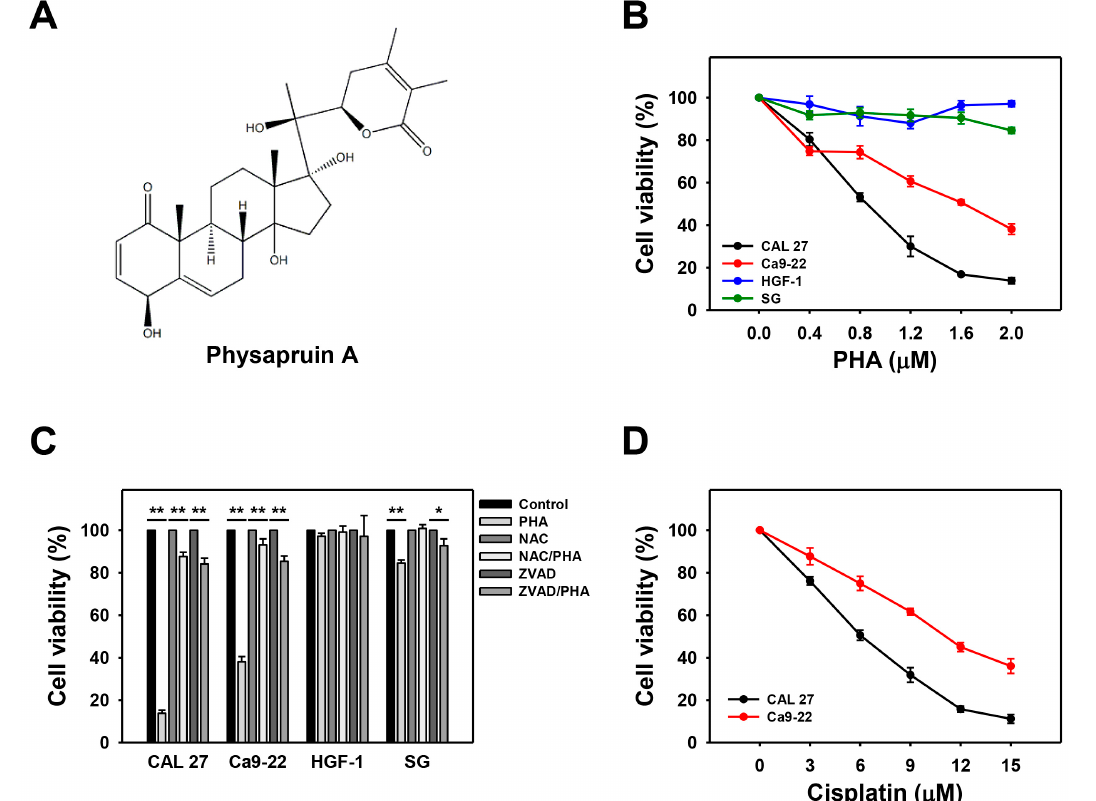
Figure 1. PHA selectively decreases the cell viabilities of oral cancer cells but not for non-malignant oral cells. ATP content after 24 h drug treatment was used for cell viability determination. ( A ) Structure of PHA. ( B ) Cell viability ATP assay. Two oral cancer (CAL 27 and Ca9-22) and two non-malignant oral (HGF-1 and SG) cell lines were examined. Cells were exposed to 0 (0.1% DMSO medium as control), 0.4, 0.8, 1.2, 1.6, and 2 µ M PHA for 24 h. ( C ) Suppression of PHA-induced antiproliferation by N -acetylcysteine (NAC) or Z-VAD-FMK (ZVAD). To evaluate the recovery effect of NAC and ZVAD, NAC (10 mM for 1 h) or ZVAD (100 µ M for 2 h) were added to cells before a 24 h treatment with PHA (control (0.1% DMSO medium) and 2 µ M), i.e., NAC/PHA or ZVAD/PHA. ( D ) Cisplatin sensitivity to oral cancer cell lines at 24 h ATP assay. Data, means ± SDs ( n = 3 independent experiments); * and ** indicate p < 0.05 and